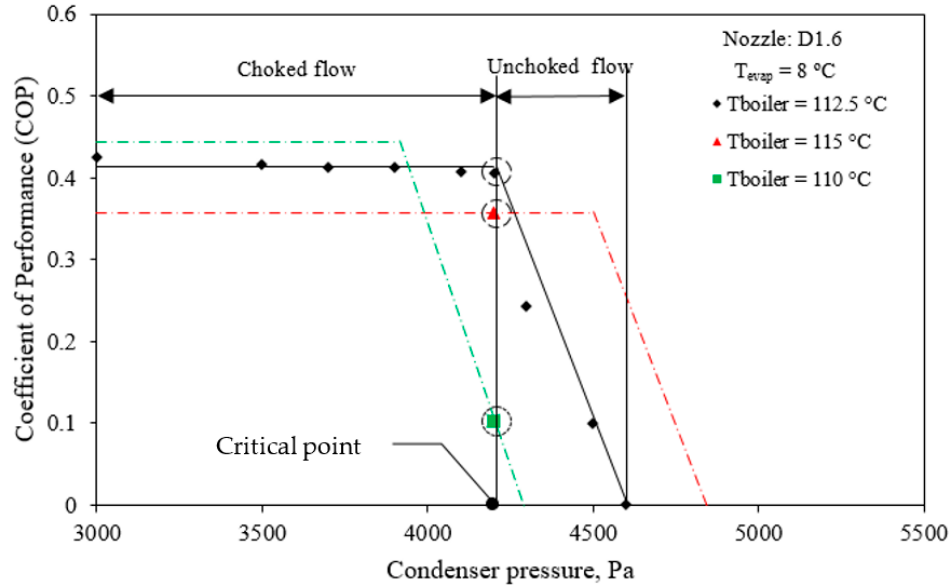
Figure 4. The conventional performance curve.